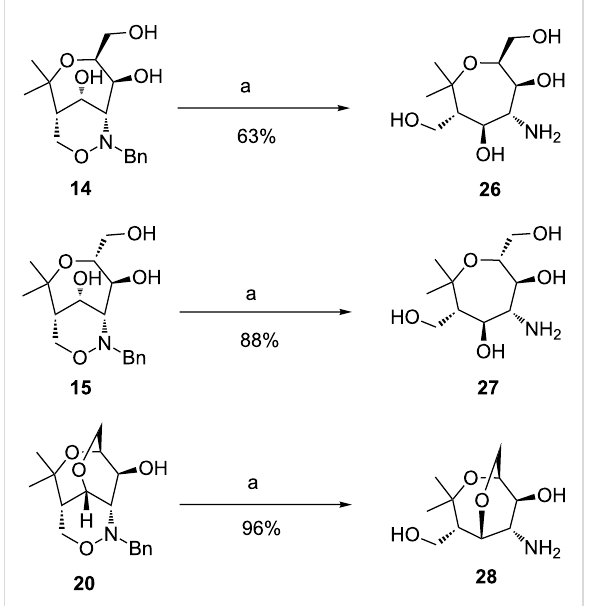
Scheme 9: Hydrogenolyses of bicyclic and tricyclic 1,2-oxazines 14 , 15 and 20 to aminooxepanes 26 , 27 and 28 . Conditions: a) H 2 , Pd/C, MeOH, rt, 18 h.